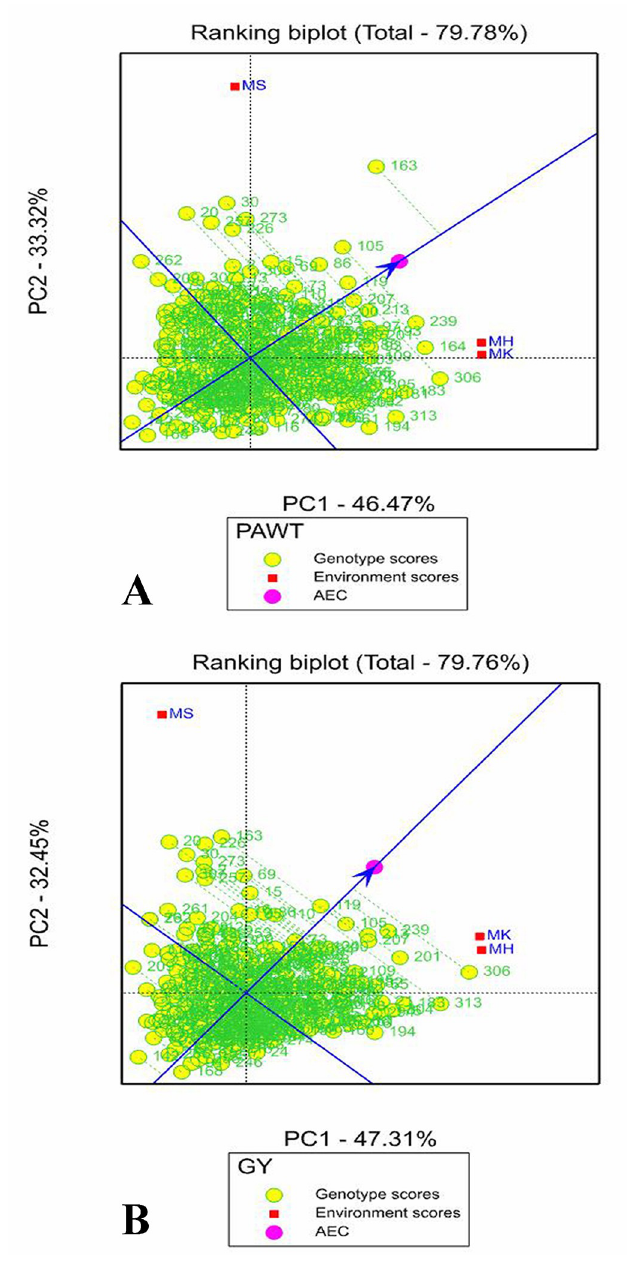
Fig 5. Genotype focus scaling of GGE biplot showing stability and mean ranking of the 324 sorghum genotypes for (A) Panicle weight (PAWT) and (B) Grain yield (GY). The blue arrowhead line that passes through the origin shows higher mean performance of a genotype and the green dotted lines extending from the blue arrowhead line show the stability of the genotypes (the shorter the dotted line the higher the stability of the genotype). most stable whereas G20 were the least stable genotypes (Fig 5A). Genotypes G244 and G118, for PALH, genotypes G261 and G5 for PAWD, genotypes G255 and G244 for PH were the most stable with a shorter vector from AEA. Genotype G313 was the least stable for both pani- cle length and width and genotype G153 was the least stable for PH (S3 Fig).